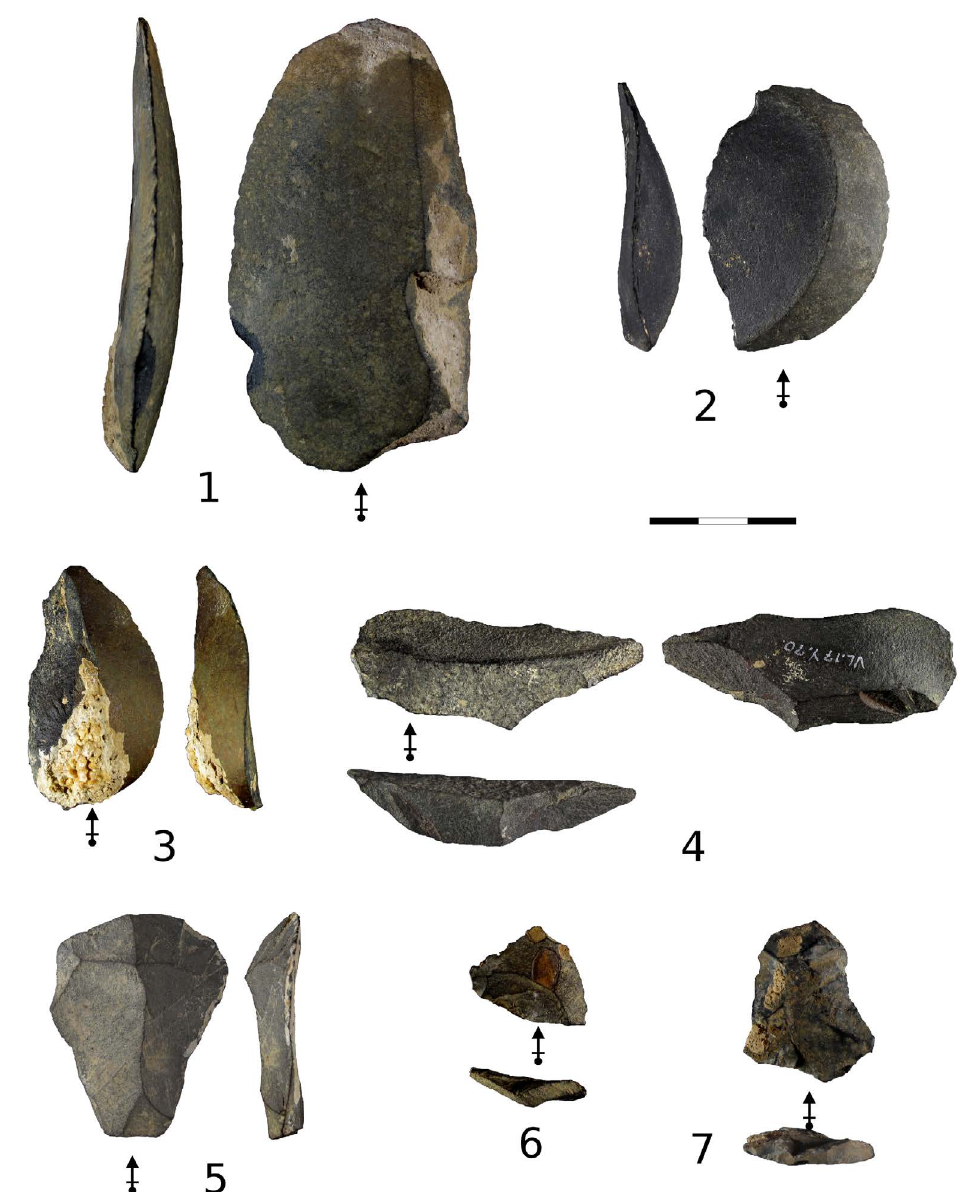
Figure 8. Mudstone products. 1-3: partially cortical flakes; 4: by-product of bifacial shaping; 5-7: non-cortical flakes with centripetal negatives and dihedral platforms (6-7). Ventalaperra level